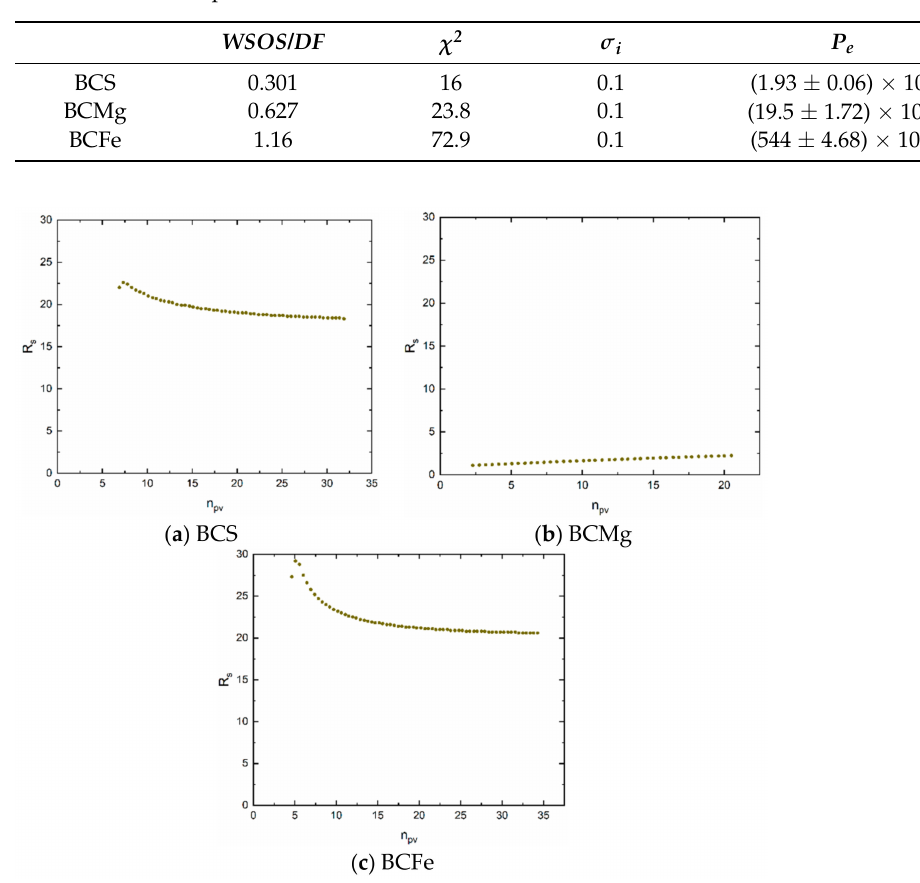
Table 9. Calculated parameters and fit criterion.